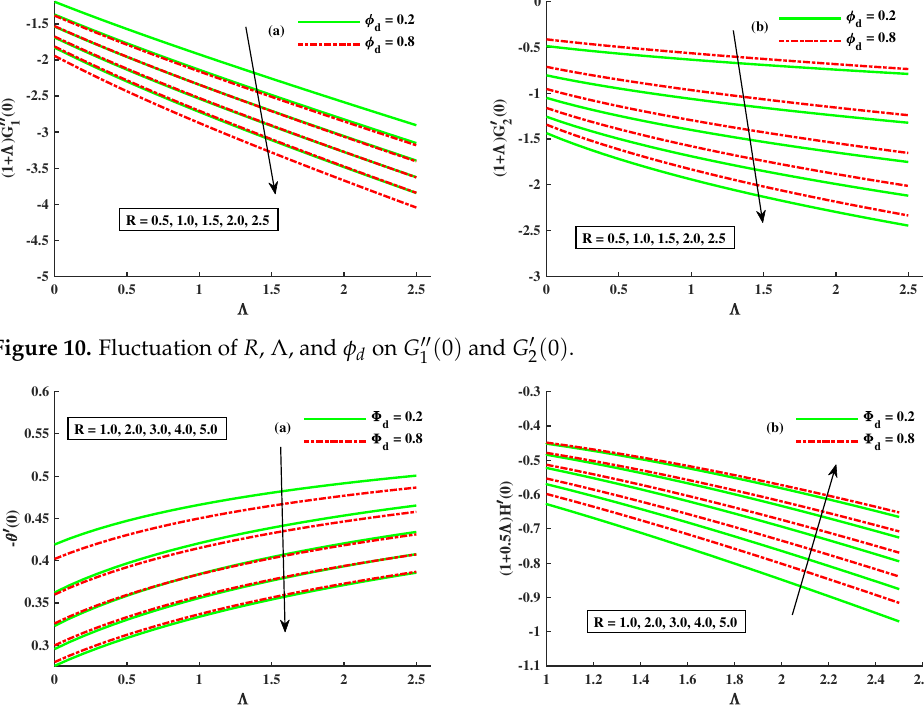
Figure 11. Fluctuation of R , Λ , and φ d on Nusselt number and couple